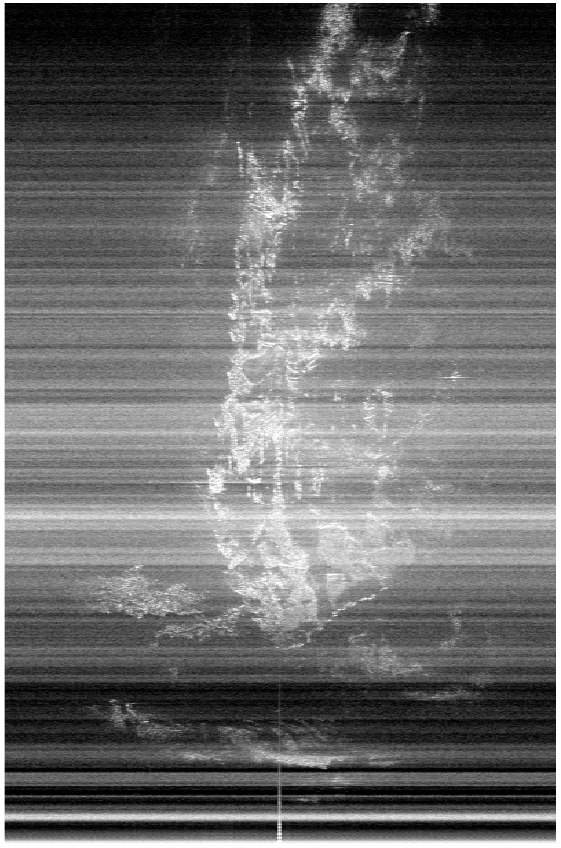
Figure 3: example of GBSAR amplitude image.